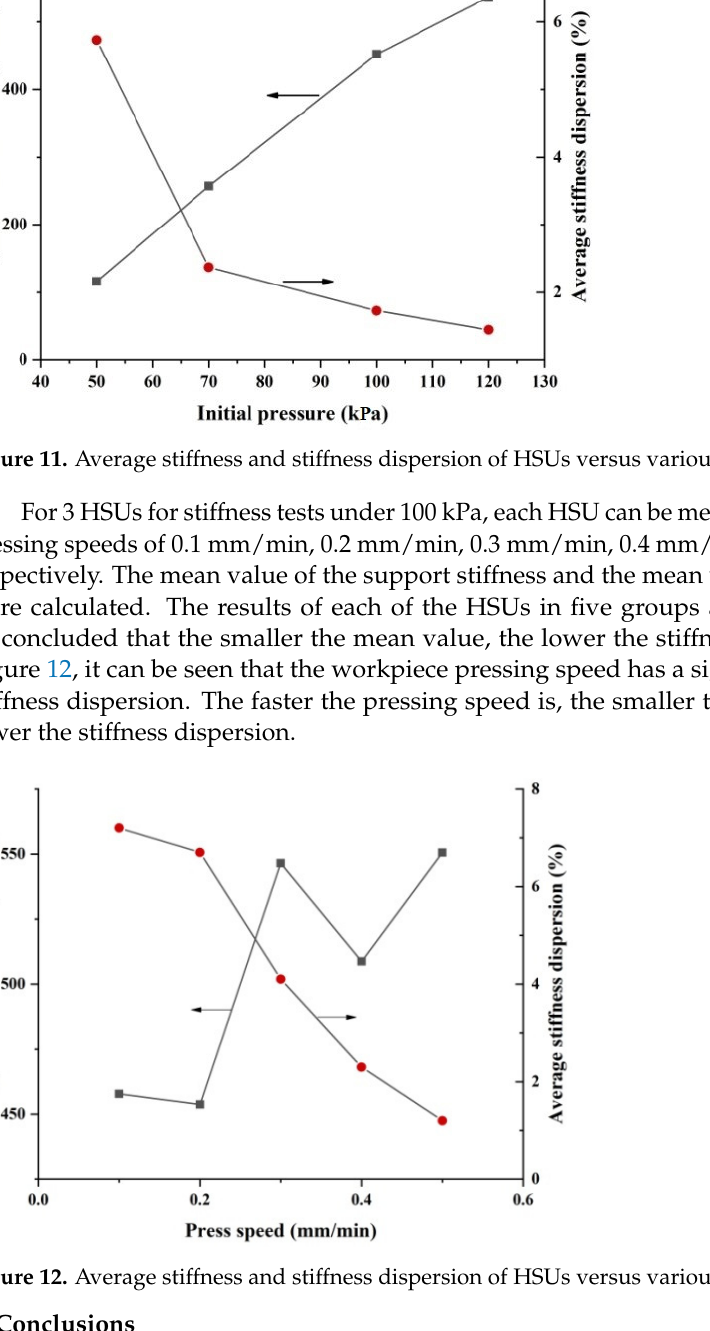
Figure 12. Average stiffness and stiffness dispersion of HSUs versus various press speeds.